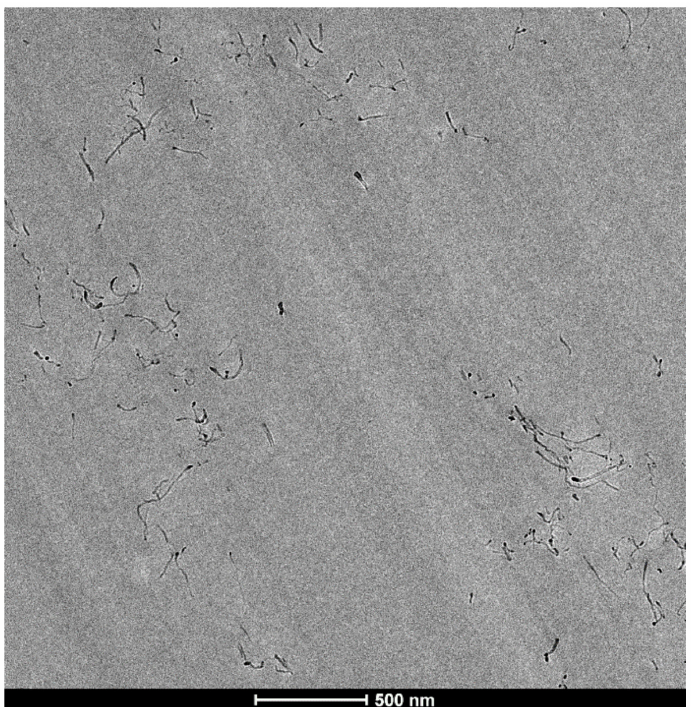
Figure 3. TEM micrograph of the IL-P-DCA-cured epoxy/PCL/CNT